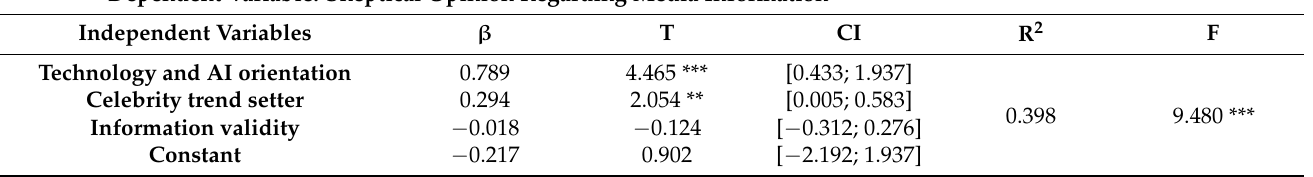
Table 3. Regression model for cluster 1.